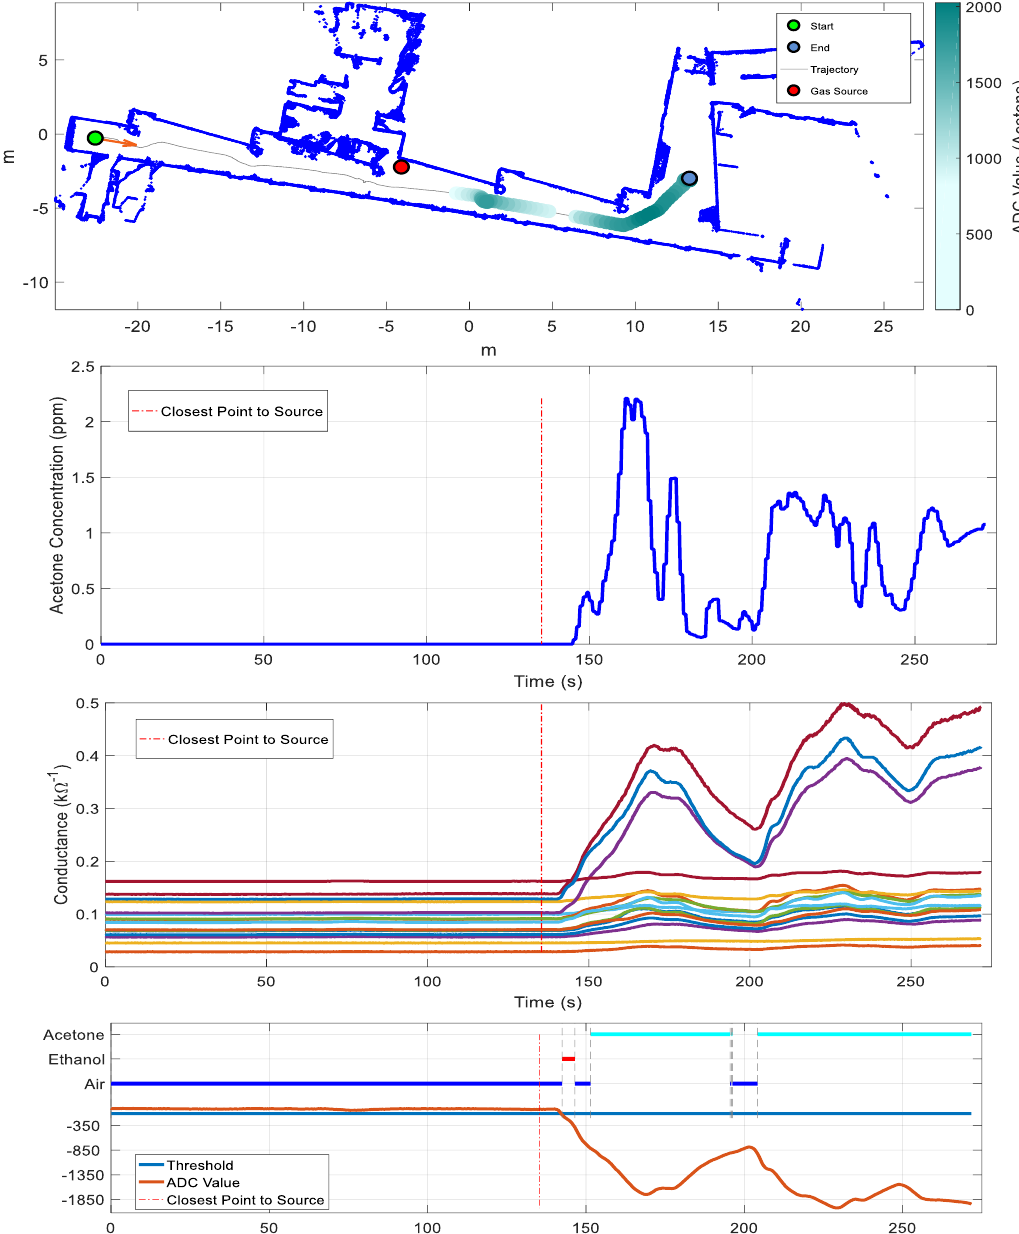
Figure 8. Results of exploration with one gas source of acetone (Scenario I). From top to bottom: map of the arena (built by the robot) and mean sensor array response overlaid on the robot trajectory; concentration measured by the PID; conductance of the matrix of MOX gas sensors; output of the PLS-DA classifier and mean sensor array response (ADC value) (for visual clarity, we added a threshold that indicates the mean array response during the commutation from air to ethanol). The red dotted line indicates the point of closest approximation to the gas source.